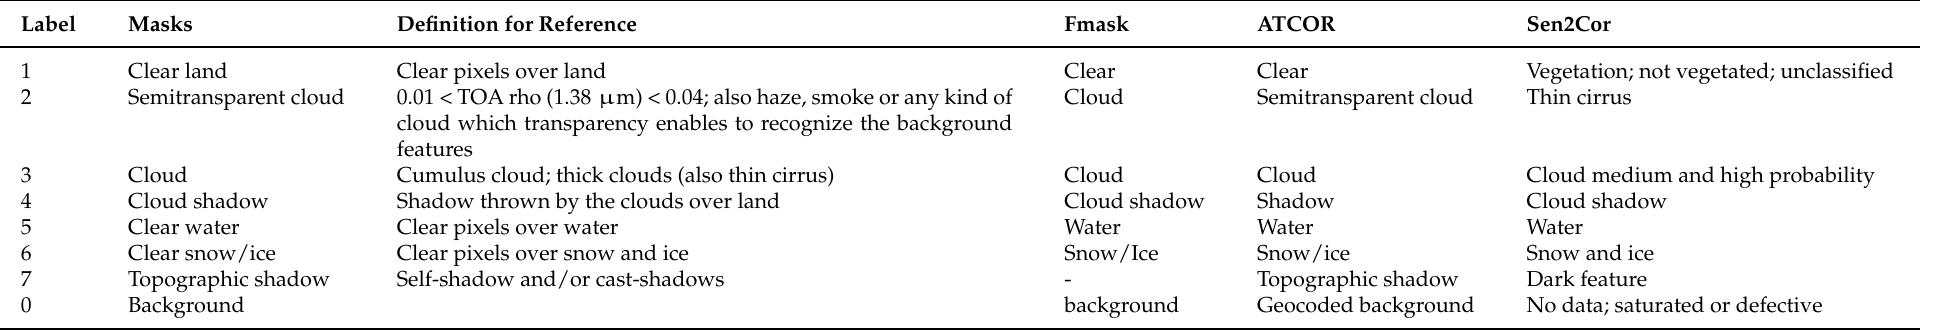
Table 3. Consolidation of individual masking outputs to common mask labels. Reference mask and corresponding mask of selected